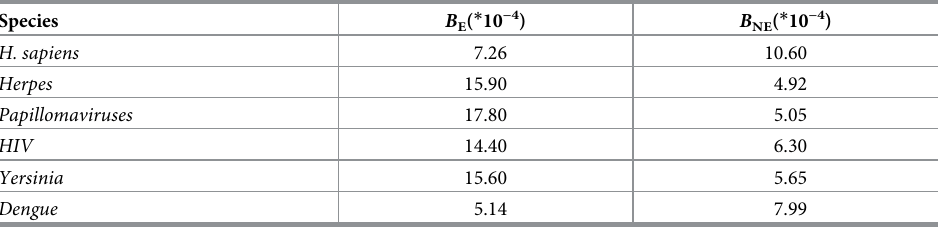
Table 2. The average betweenness centrality values of the essential genes ( B E ) and non-essential genes ( B NE ) for six species. Species B E ( * 10 − 4 ) B NE ( * 10 − 4 ) H.